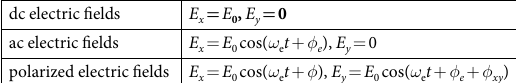
response functions has been presented in an arbitrary model with differentiable right-hand sides 27, 41 . By using the response function theory, the drift laws for spiral waves on curved anisotropic surfaces were investigated. And an asymptotic theory that predicts the drift of spiral waves on general curved surfaces with the anisotropic diffusion has been developed 42 . The response function theory has also been used to study the change of the filament tension for scroll waves caused by a circularly polarized electric field 43 .